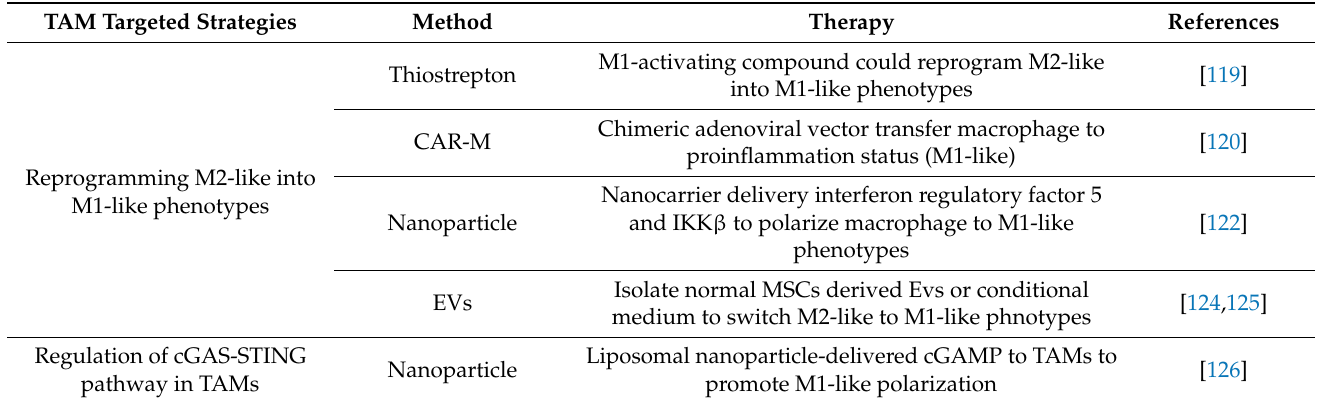
Table 2. TAM-targeted therapy in preclinical